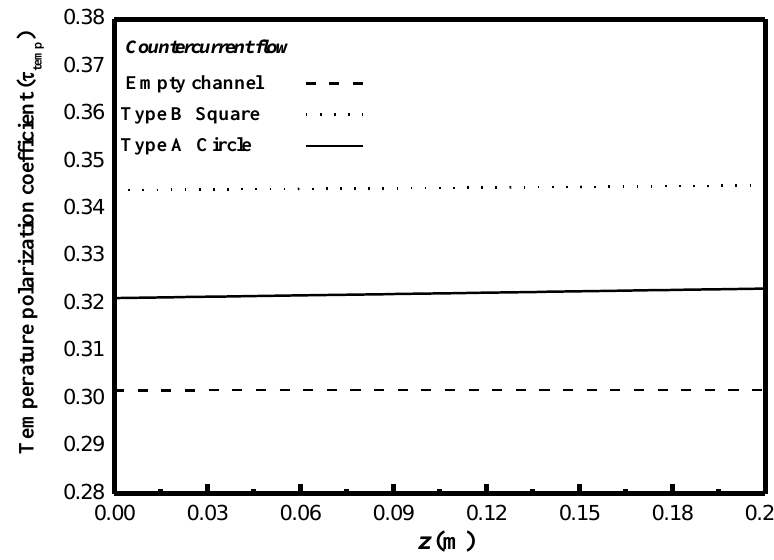
Figure 13. Effects of geometric shapes on temp of countercurrent-flow operations.